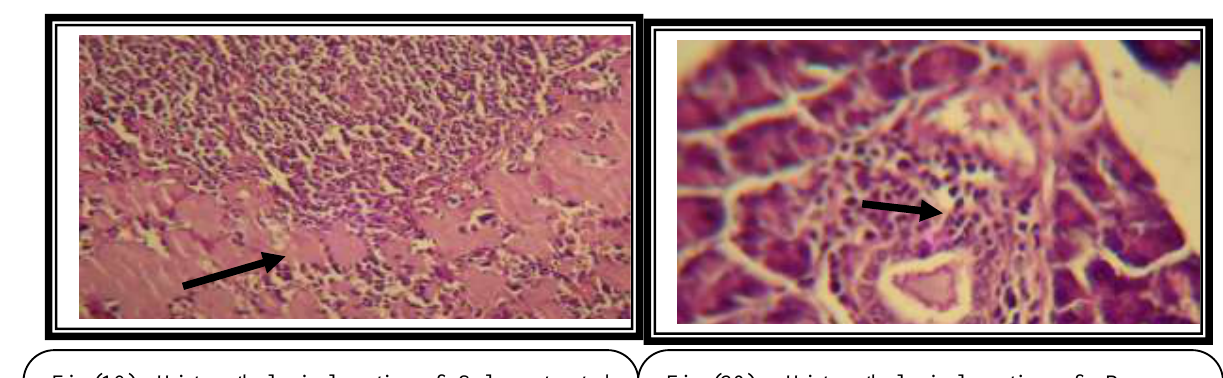
Fig (20): Histopathological section of Pancreas treated with ethanolic extract of grape seed at dose (300mg/kg b.w orally) showing infiltration of mononuclear cells around pancratic duct with slight fibrosis (H&E x400).